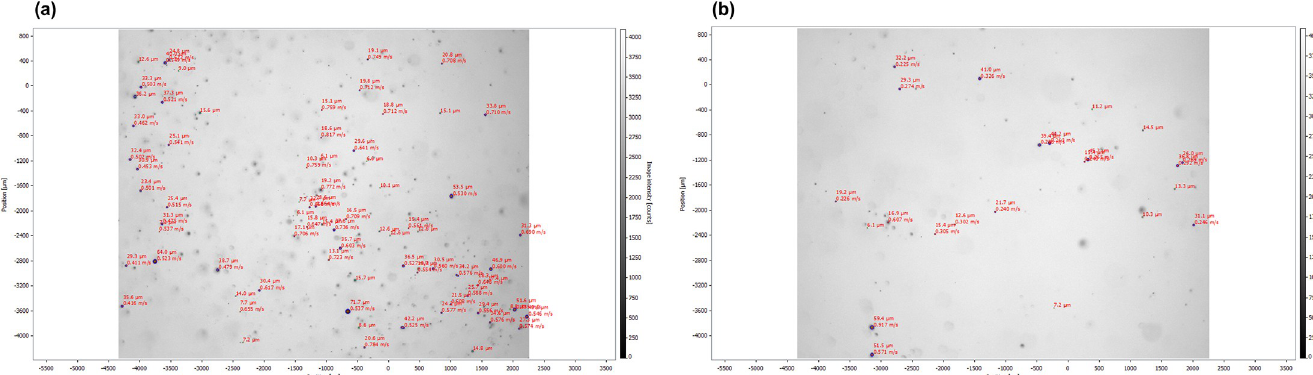
Fig 3. Example illustration of the distribution of the particles in a spray mist cloud by low flow rate (FR-2) of the HVE for (a) suboptimal versus (b) optimal positioned 16 mm sized cannula. Of the distribution of the particles in a spray mist cloud caused by a dental turbine and an intraoral high-volume evacuation system (HVE) set to a low flow rate of FR-2 > 120 � 160 l/min with the imaging process technique (ParticleMaster, Lavision, Go¨ttingen, Germany); (a) suboptimal positioned 16 mm sized cannula in the opposite jaw versus (b) optimal positioned 16 mm sized cannula near tooth preparation. The imaging software determined the number and size of particles as well as the velocity of each individual particle between 5 μ m and 50 μ